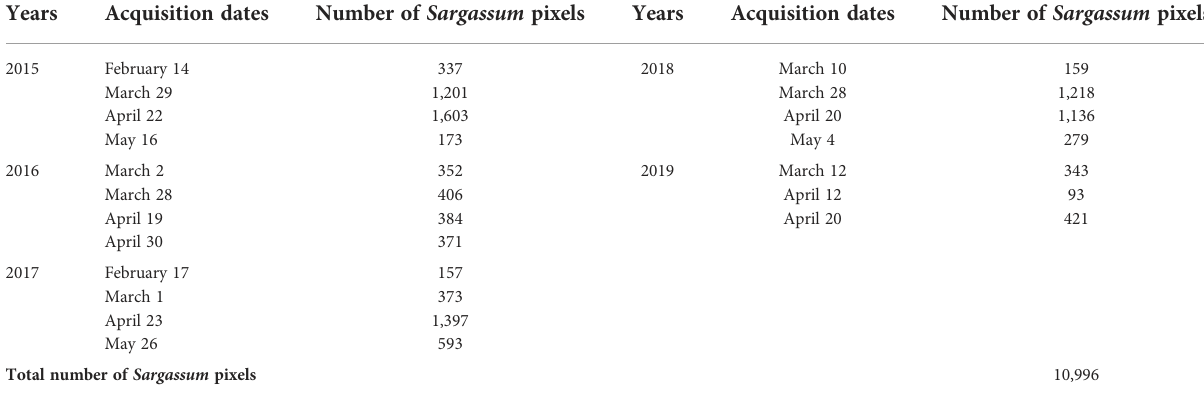
TABLE 1 Information of ground-truth data obtained from GOCI images.